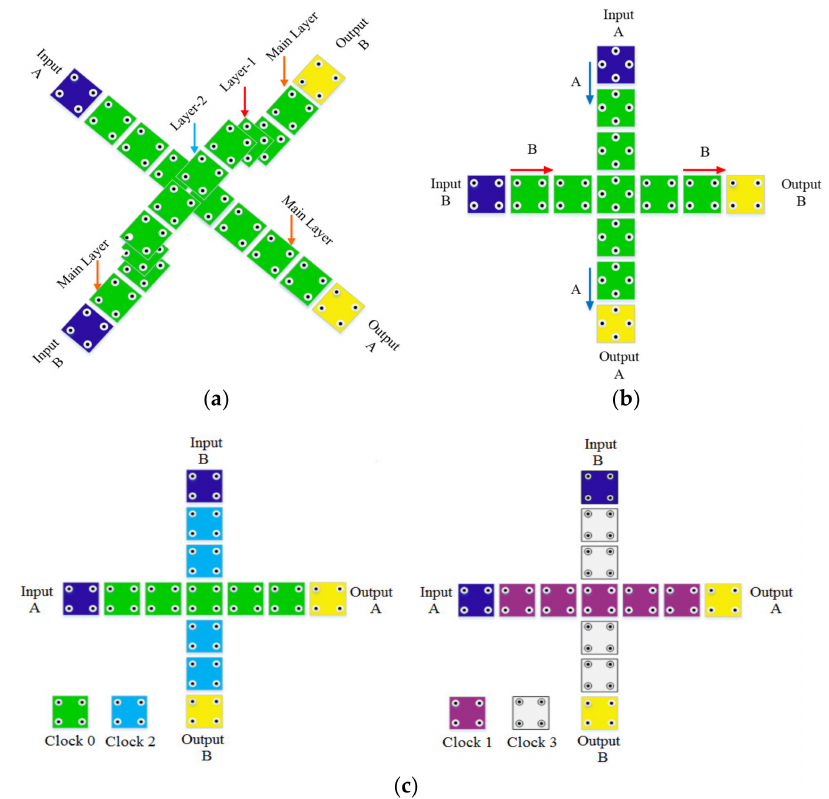
Figure 3. QCA crossover, ( a ) multilayer crossovers, ( b ) coplanar crossovers by using rotation cells, and ( c ) coplanar crossover by using standard